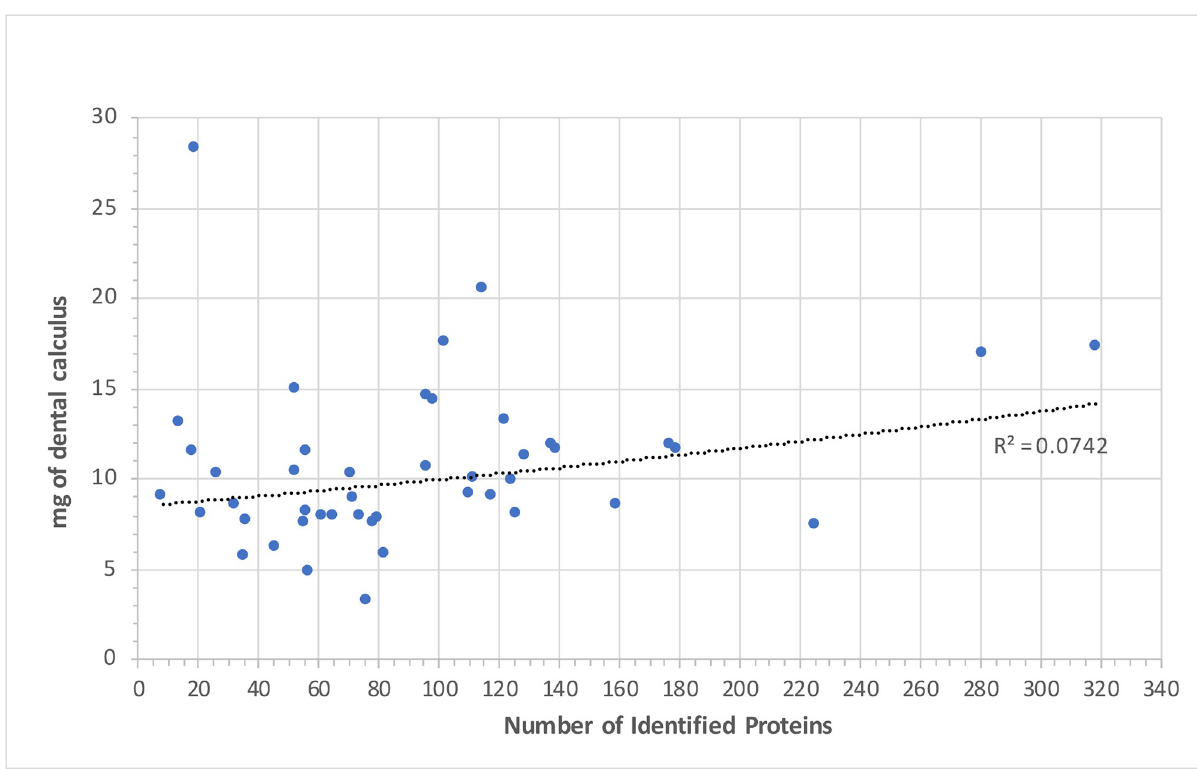
Fig 7. Relationship between quantity (mg) of starting material and number of identified